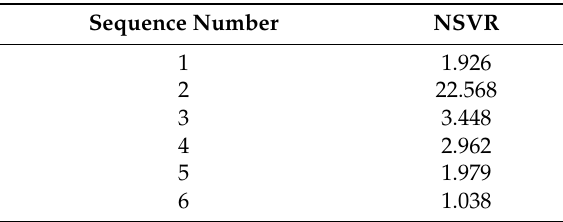
Table 3. The ratios of neighboring singular values.